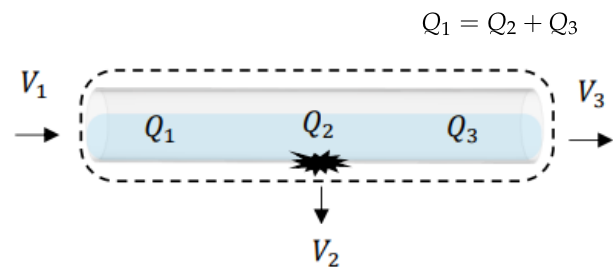
Figure 5. Schematic of broken pipeline and parameters.